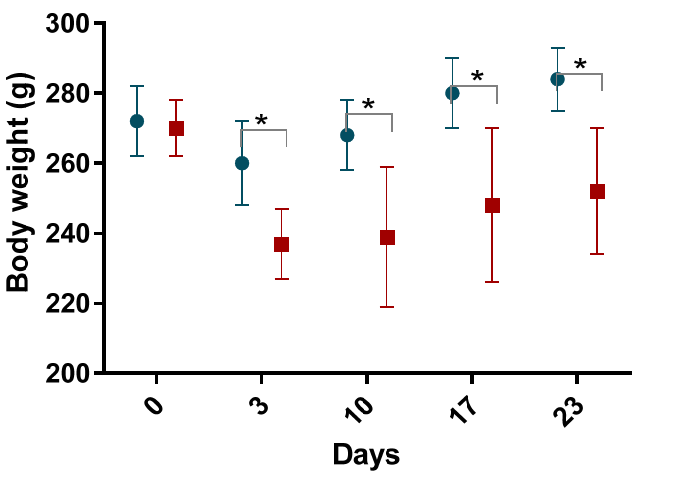
Figure 3. Body weight of rats after MCAO. Body weight was measured regularly. Mass is presented in grams. Compound 4 —green. Normal saline—red. ANOVA test was used for significance calculation. * p < 0.05. Data are presented as mean and SD, p = 0.0028.